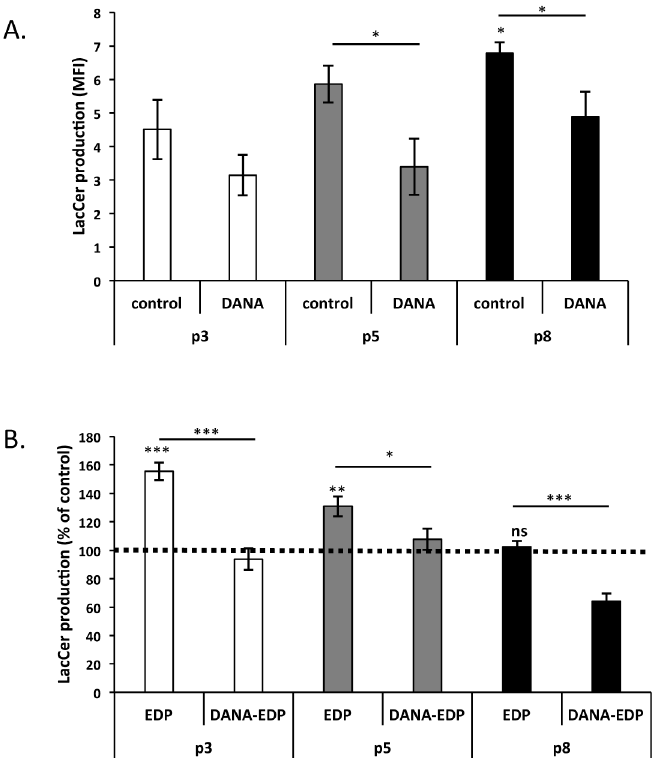
Fig 6. Impact of aging on EDP-induced LacCer production. Young, intermediate and aged fibroblasts were represented by passage 3 (white), 5 (gray) and 8 (black), respectively. (A) Basal LacCer production increases with age. LacCer production was detected by flow cytometry using a specific FITC-coupled anti- LacCer antibody (anti-CD17). DANA was used to study the impact of sialidase inhibition on basal production of LacCer during in vitro aging. (B) EDP-mediated LacCer production is altered with age. Cells were stimulated or not with 50 μ g/mL of EDP for 30 minutes in the presence or not of DANA. LacCer production was then analyzed by flow cytometry as described above. Histograms represent the normalized results relative to the control expressed in percent. Each data is representative of three independent experiments. * , p < 0.05, *** , p < 0.01. Dotted lines represent the values of the unstimulated